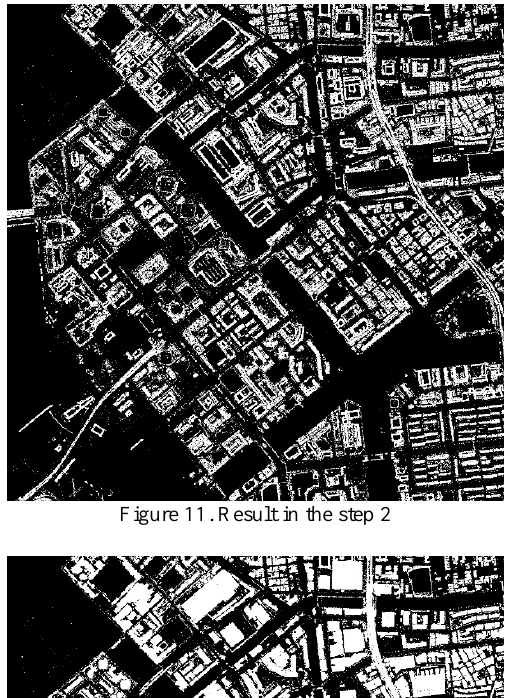
Figure 11. Result in the step 2